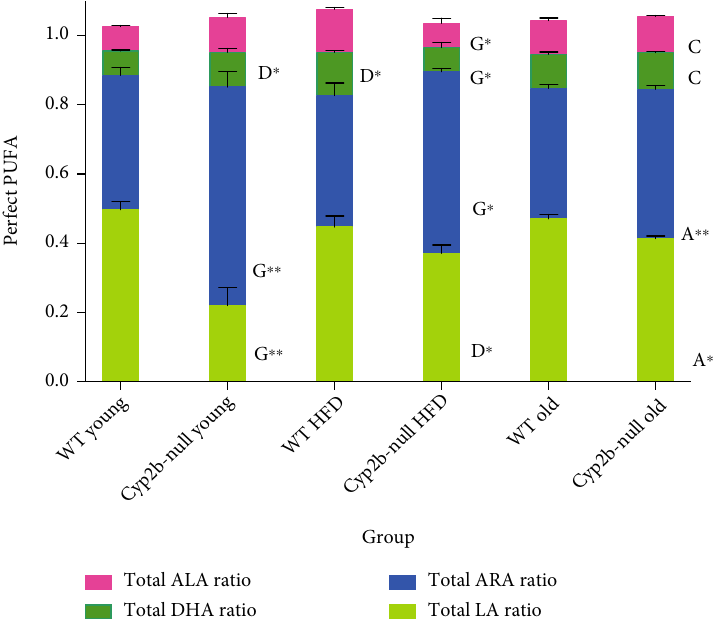
Figure 7: Ratio of each measured lipid (ALA, ARA, DHA, and LA) to total lipids. Data are presented as mean ð g Þ ± SEM . Statistical signi fi cance was determined by one-way ANOVA multiple comparison test with Tukey ’ s as the post hoc test ( n = 3 − 5 ). “ a ” indicates age di ff erence between young (4.5mo) and old (9 mo) mice within same genotype and diet group, “ c ” indicates di ff erence between HFD-fed young (4.5 mo) and ND-fed old (9 mo) mice within same genotype, “ d ” indicates diet di ff erence between ND-fed and HFD-fed mice within in same genotype and age, and “ g ” indicates genotype di ff erence between WT and Cyp2b-null mice within same diet and age group. No asterisk indicates a p value < 0.05, ∗ indicates a p value < 0.01, and ∗∗ indicates a p values < 0.0001. The ratio of each lipid is to the total (1.0) within a sample; however, average of each lipid type within a group varied, and therefore, the totals for each group do not necessarily equal